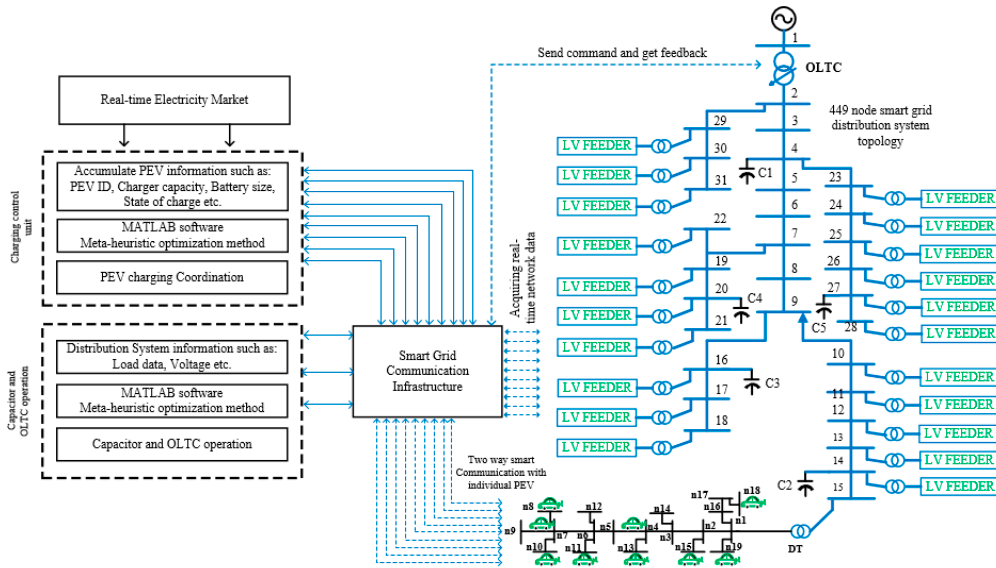
Figure 2. The functional diagram of PEV charging coordination in smart grid.